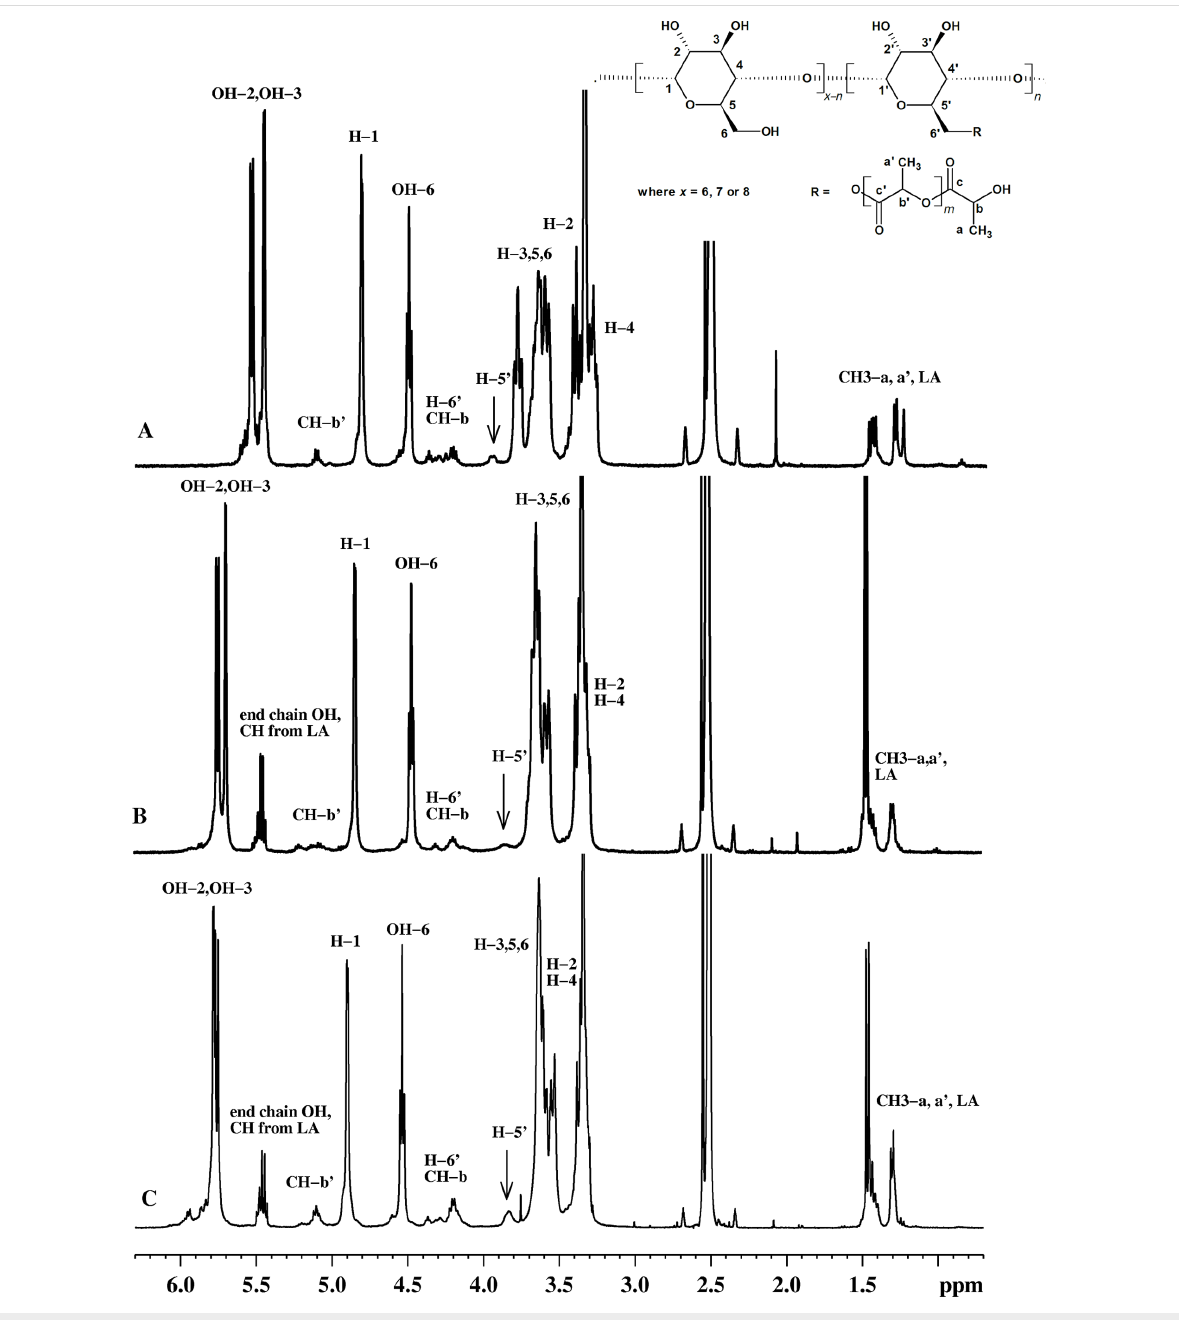
Figure 4: 1 H NMR spectrum of fractions precipitated in THF of (A) α -CD-LA, (B) β -CD-LA and (C) γ -CD-LA.